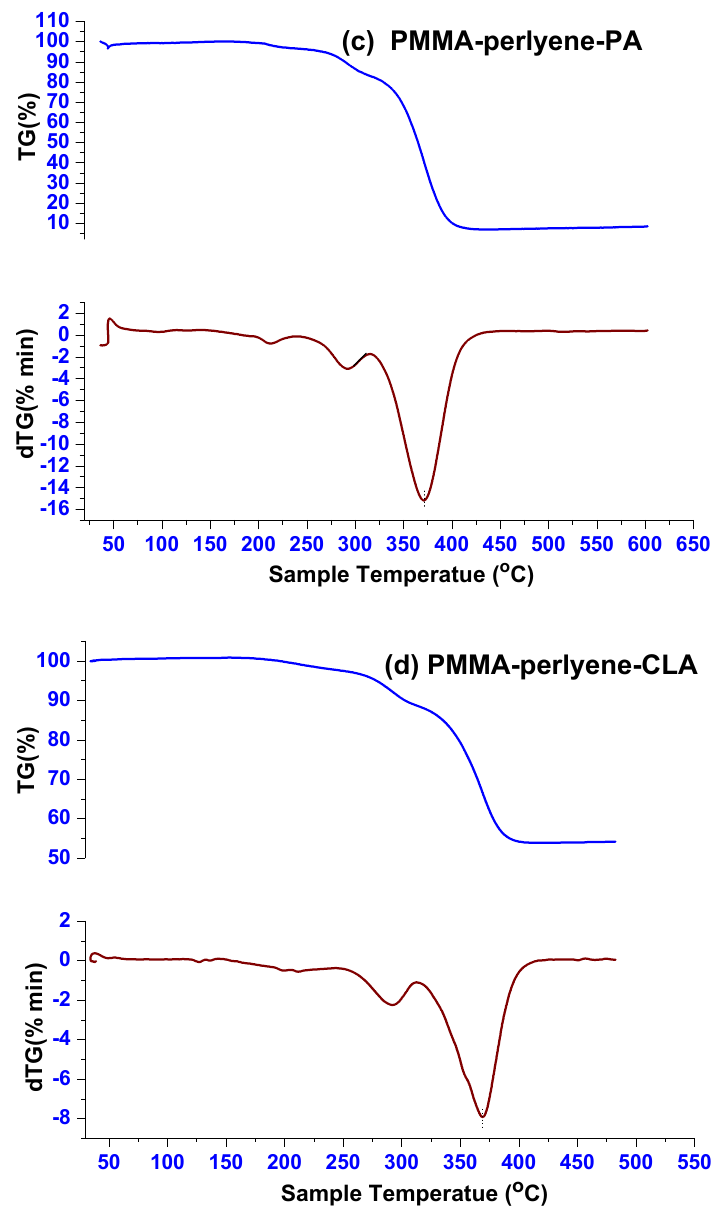
Figure 2. ( a ) TG and dTG curves of free PMMA polymer sheet; ( b ) TG and dTG curves of PMMA- perylene polymer sheet; ( c ) TG and dTG curves of PMMA-perylene-PA polymer sheet; ( d ) TG and dTG curves of PMMA-perylene-CLA polymer sheet.